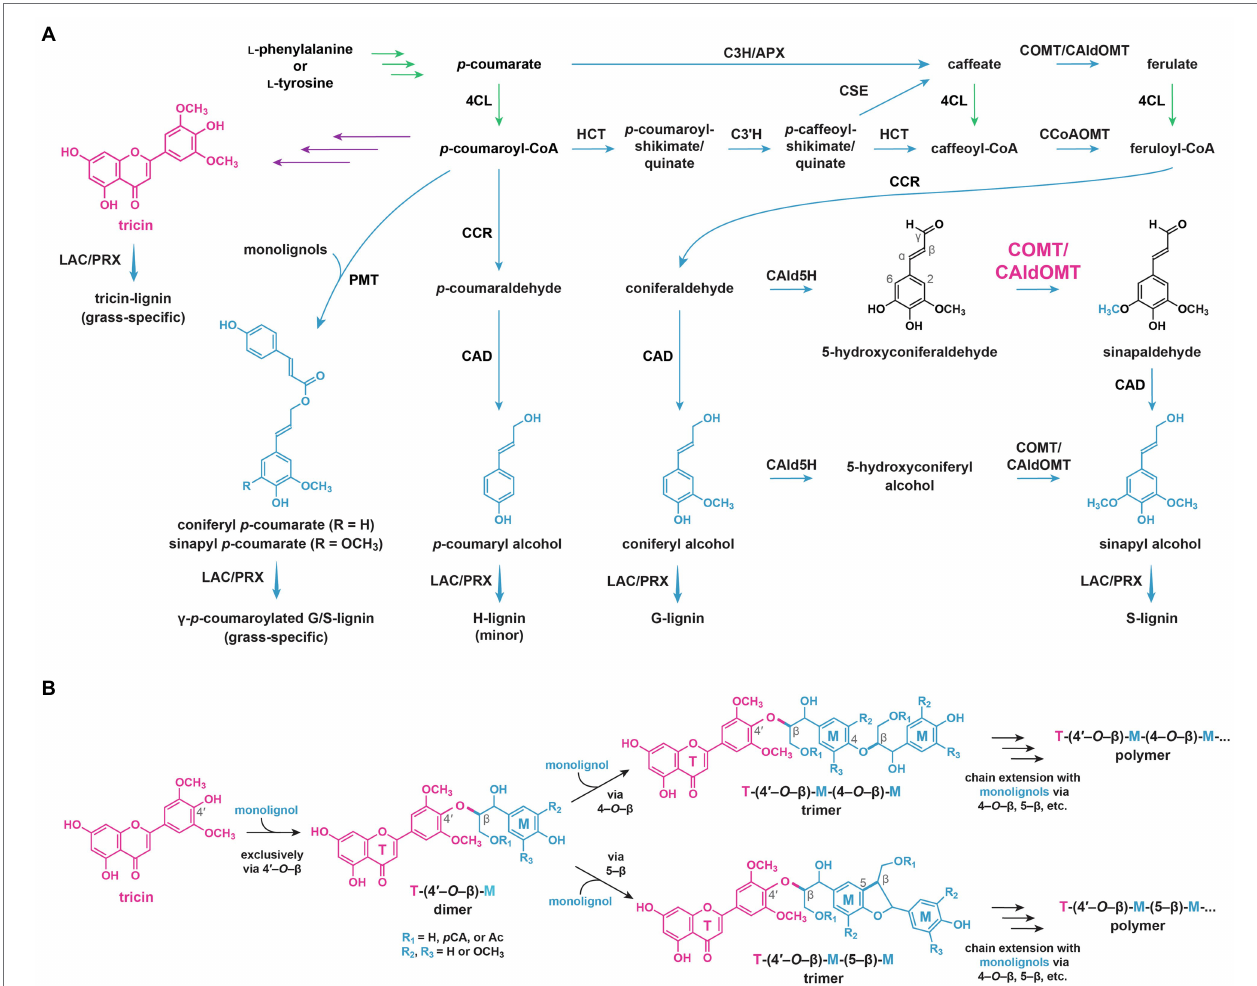
FIGURE 7 | Current understanding on lignin biosynthesis in grasses. (A) Monolignol biosynthetic pathways. Major activity of COMT/CAldOMT in monolignol biosynthetic pathways is indicated. (B) Radical coupling of tricin and monolignols to produce tricin-lignin polymers. 4CL, 4-hydroxycinnamate:CoA ligase; C3H, p -coumarate 3-hydroxylase; HCT, p -hydroxycinnamoyl-CoA:quinate/shikimate esterase; APX, ascorbate peroxidase; C3 ' H, p -coumaroyl ester 3-hydroxylase; CSE, caffeoyl shikimate esterase; CCoAOMT, caffeoyl-CoA O -methyltransferase; CAld5H, coniferaldehyde 5-hydroxylase; COMT, caffeic acid O -methyltransferases; CAldOMT, 5-hydroxyconiferaldehyde O -methyltransferase; CCR, cinnamoyl-CoA reductase; CAD, cinnamyl alcohol dehydrogenase; PMT, p -coumaroyl- CoA:monolignol transferase; LAC, laccase; and PRX, peroxidase. In green: general phenylpropanoid pathway. In purple: flavonoid biosynthetic pathways. In blue: monolignol biosynthetic pathways. T, tricin; M, monolignols and their derivatives; p CA, p -coumarate; and Ac,